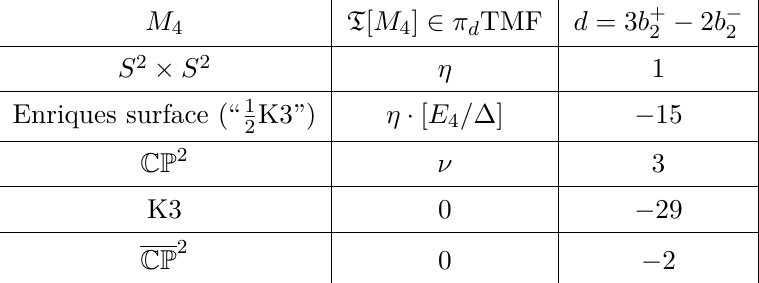
tmf ∼ = Z and π tmf ∼ = Z respectively, and [ E 1 2 3 24 tmf is understood as a ∗